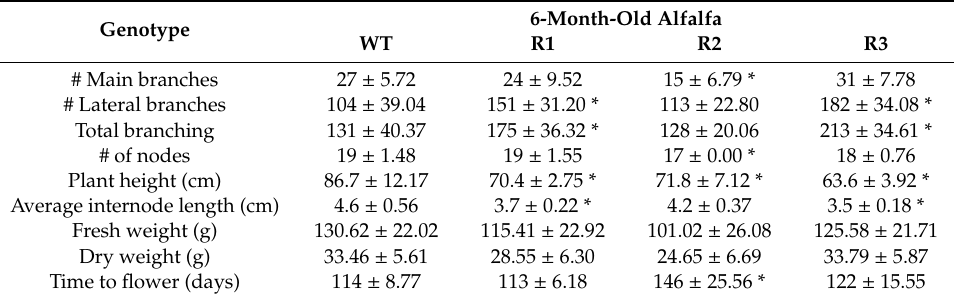
Table 2. Physiological traits measured in six-month-old WT and SPL9 -RNAi transgenic alfalfa: the asterisks indicate significant differences between transgenic and WT plants ( p < 0.05, where n = 5–13, one-way ANOVA and Dunnett’s test).